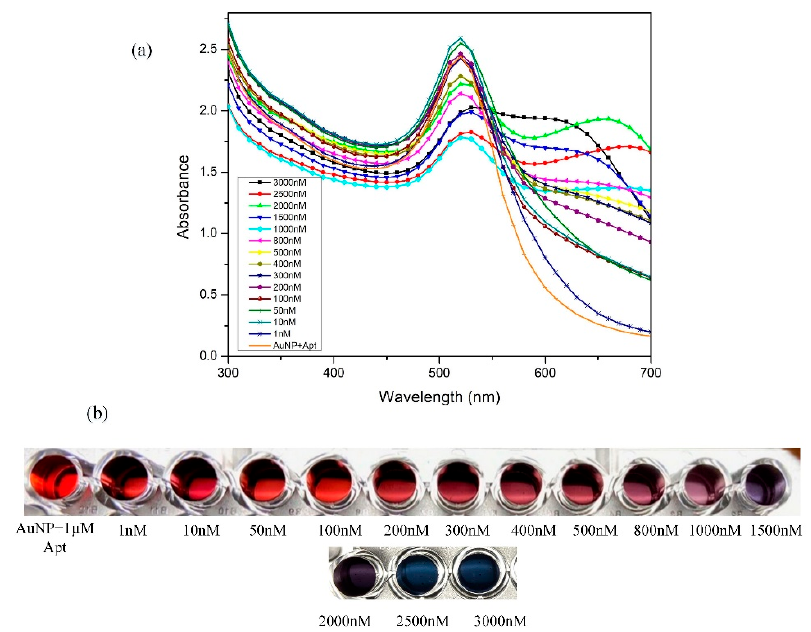
Figure 6. ( a ) Spectral data of different conditions on a 96-well plate setup: AuNP, AuNP + Aptamer and interactions with various concentration of gentamicin, and ( b ) an image of a trial experiment performed on a 96-well plate and representative concentrations labelled using 200 µL AuNP + 1 µM GA + x nM gentamicin + 280 mM NaCl.